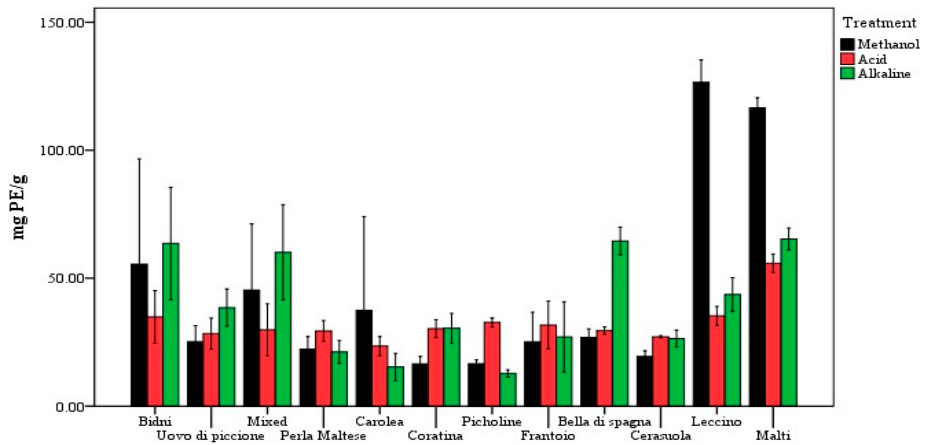
Figure 4. Mean values for total ortho-diphenolic content (TdPC) of olive mill waste extracts using three different solvent extraction methods—methanol, acid and alkaline (black, red and green bars, respectively) with error bars showing ± 1SD for three independent trails.